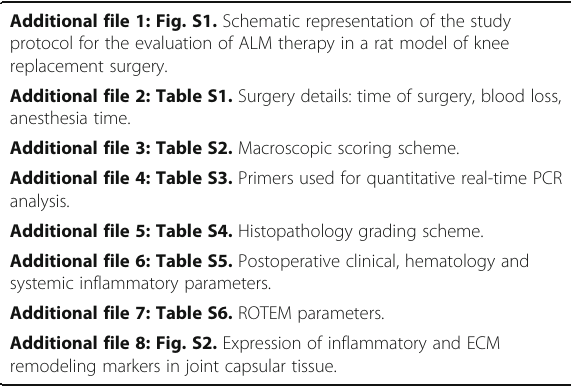
replacement surgery.